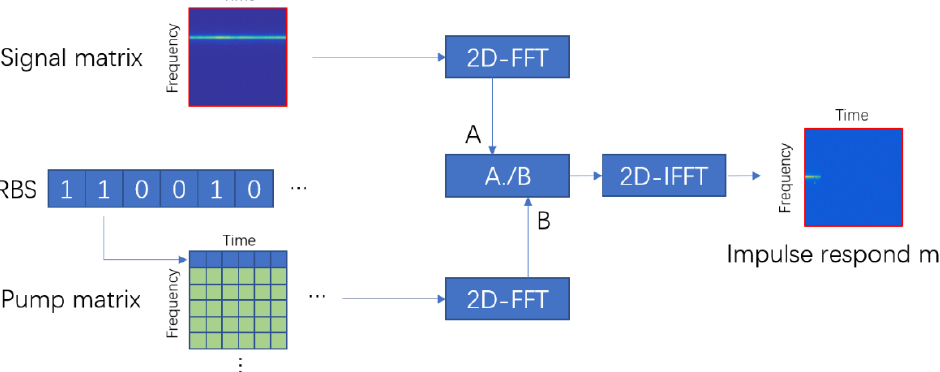
Figure 2. Impulse response matrix calculation procedure.